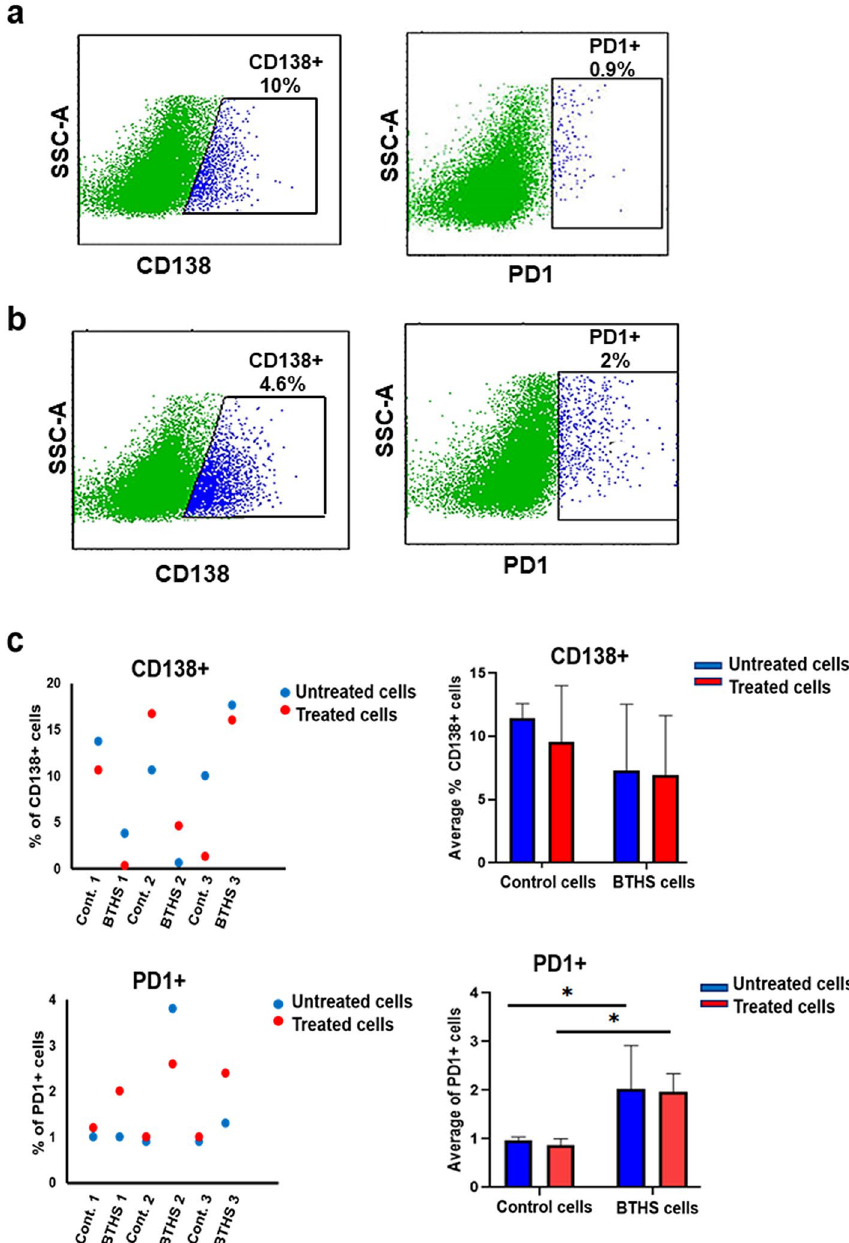
Figure 5. CD138 + and PD1 + surface markers expression in Epstein-Barr virus transformed human age- matched control and BTHS lymphoblasts after CpG DNA stimulation. The expression of CD138 + and PD1 + surface markers were determined in control and BTHS cells after stimulation without or with 5 µM CpG DNA using flow cytometry as described in “Materials and Methods”. ( a ) Representative flow cytometry images of CD138 + and PD1 + surface markers in control cells after CpG DNA stimulation. ( b ) Representative flow cytometry images of CD138 + and PD1 + surface markers in BTHS cells after CpG DNA stimulation. ( c ) Histograms showing percentage of CD138 + and PD1 + surface marker expression in CpG DNA treated control and BTHS cells compared to untreated control and BTHS cells. N = 3, * p <